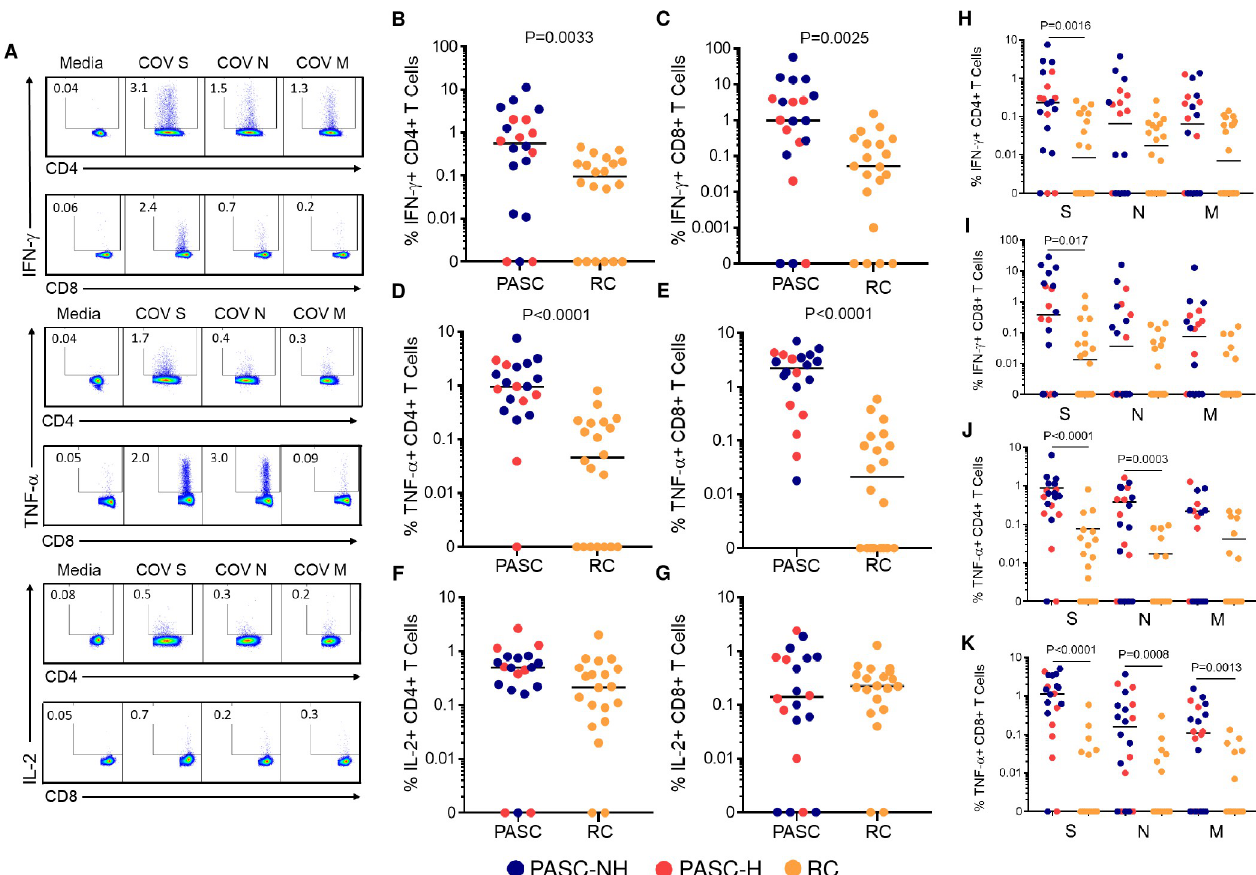
Fig 1. Cumulative and S-, N- and M- specific SARS-CoV-2 specific T cell frequencies are elevated in PASC. (A) Representative flow cytometry density plots showing the frequency of SARS-CoV-2 (S, N and M) IFN- γ -, TNF- α - and IL-2-specific T cells from a participant with PASC. The cummulative frequency of SARS-CoV-2 S, N and M IFN- γ -producing (B) CD4 + and (C) CD8 + , TNF- α -producing (D) CD4 + and (E) CD8 + and IL-2-produing (F) CD4 + and (G) CD8 + T cells are shown. For B-G each point represents the sum of the combined frequencies of SARS-CoV-2 S, N and M-specific T cells of each participant. The frequency of individual SARS-CoV-2 S-, N- or M-specific IFN- γ -producing (H) CD4 + and (I) CD8 + and TNF- α -producing (J) CD4 + and (K) CD8 + T cells are shown. The horizontal bars depict median values for each cohort. Blue: PASC-NH (not hospitalized), red: PASC-Hospitalized and orange: RC participants. Mann-Whitney tests were used to determine statistical